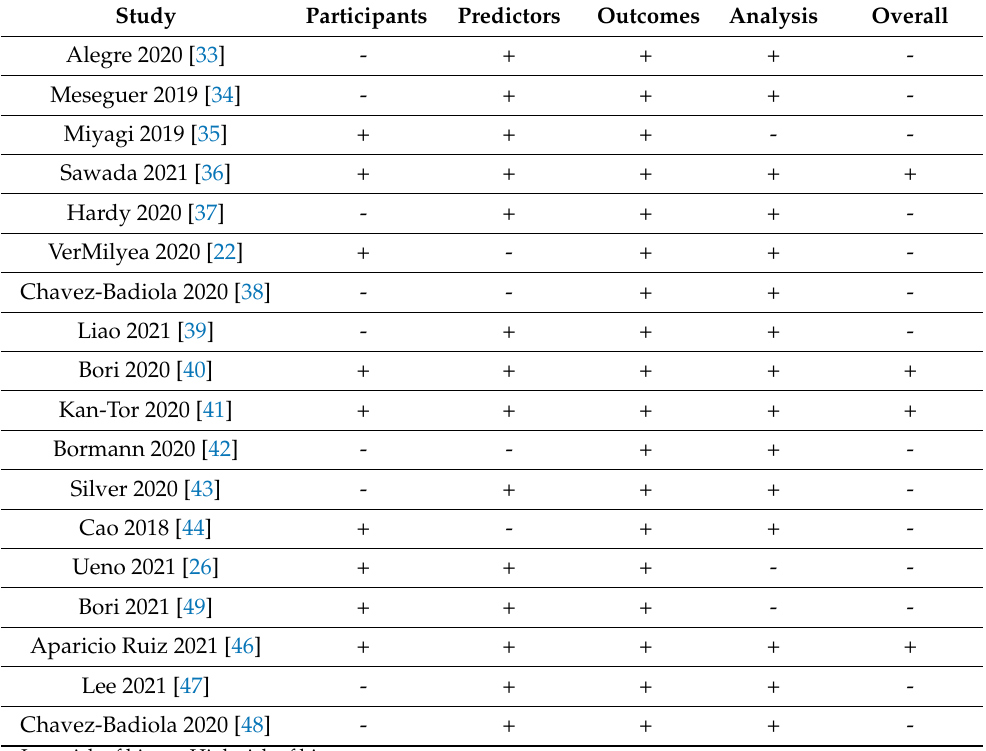
Table 2. Assessment of